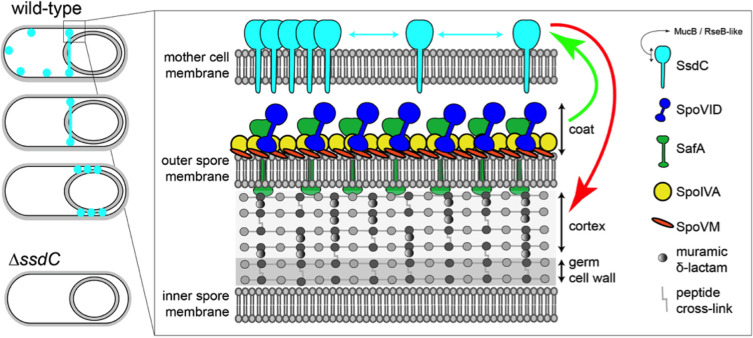
Model illustrating the relationship of SsdC with the spore coat and cortex.Schematic representation of SsdC localization and its relationship to the spore cortex and coat. The green arrow represents the localization relationship between SsdC and the coat, and the red arrow represents the shape relationship between SsdC and the cortex. We hypothesize that SsdC influences the assembly of the cortex through the spore coat and may act to coordinate the assembly of these two spore envelope layers. In this model, SafA crosses the spore outer membrane. Although recent data suggests that SafA can interact with cortex peptidoglycan in mature spores and efficient localization of SafA depends on cortex synthesis [56], it remains unclear if SafA actually transverses the membrane to do so, or if the forespore outer membrane becomes permeable, or disappears, as the spores mature.